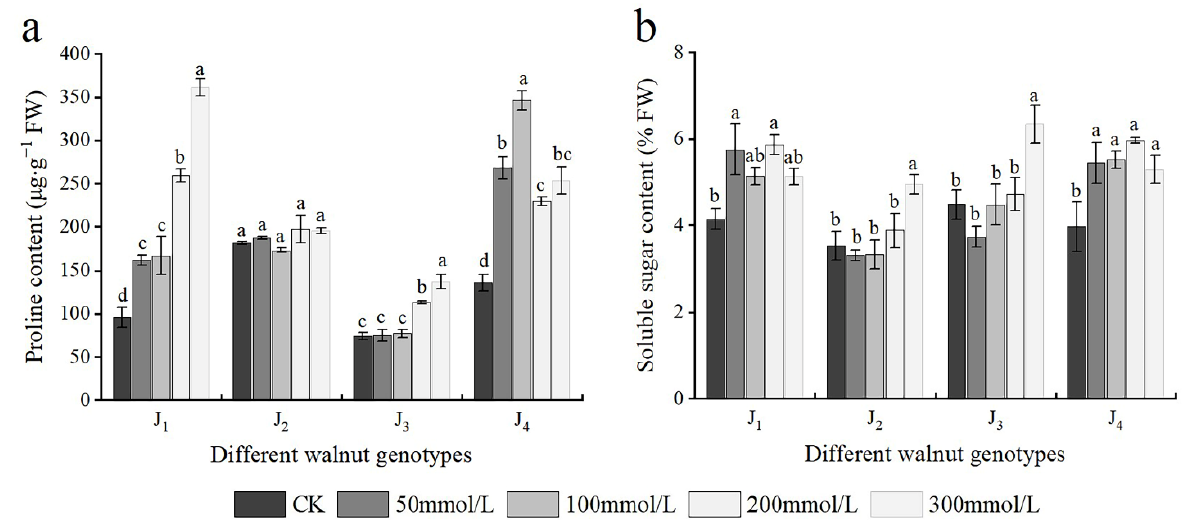
Figure 6. Effect of salt stress on the osmotic adjustment substances of walnut. ( a ) Proline (Pro) content, ( b ) soluble sugar (SS) content in the leaves. Four walnut genotypes were grown under different NaCl concentrations (0, 50, 100, 200, and 300 mmol/L) for 28 days. Each value indicates the mean ± standard error (SE) of three biological replicates. Bars of each parameter labeled by different letters are significantly different ( p < 0.05) by Duncan’s test.